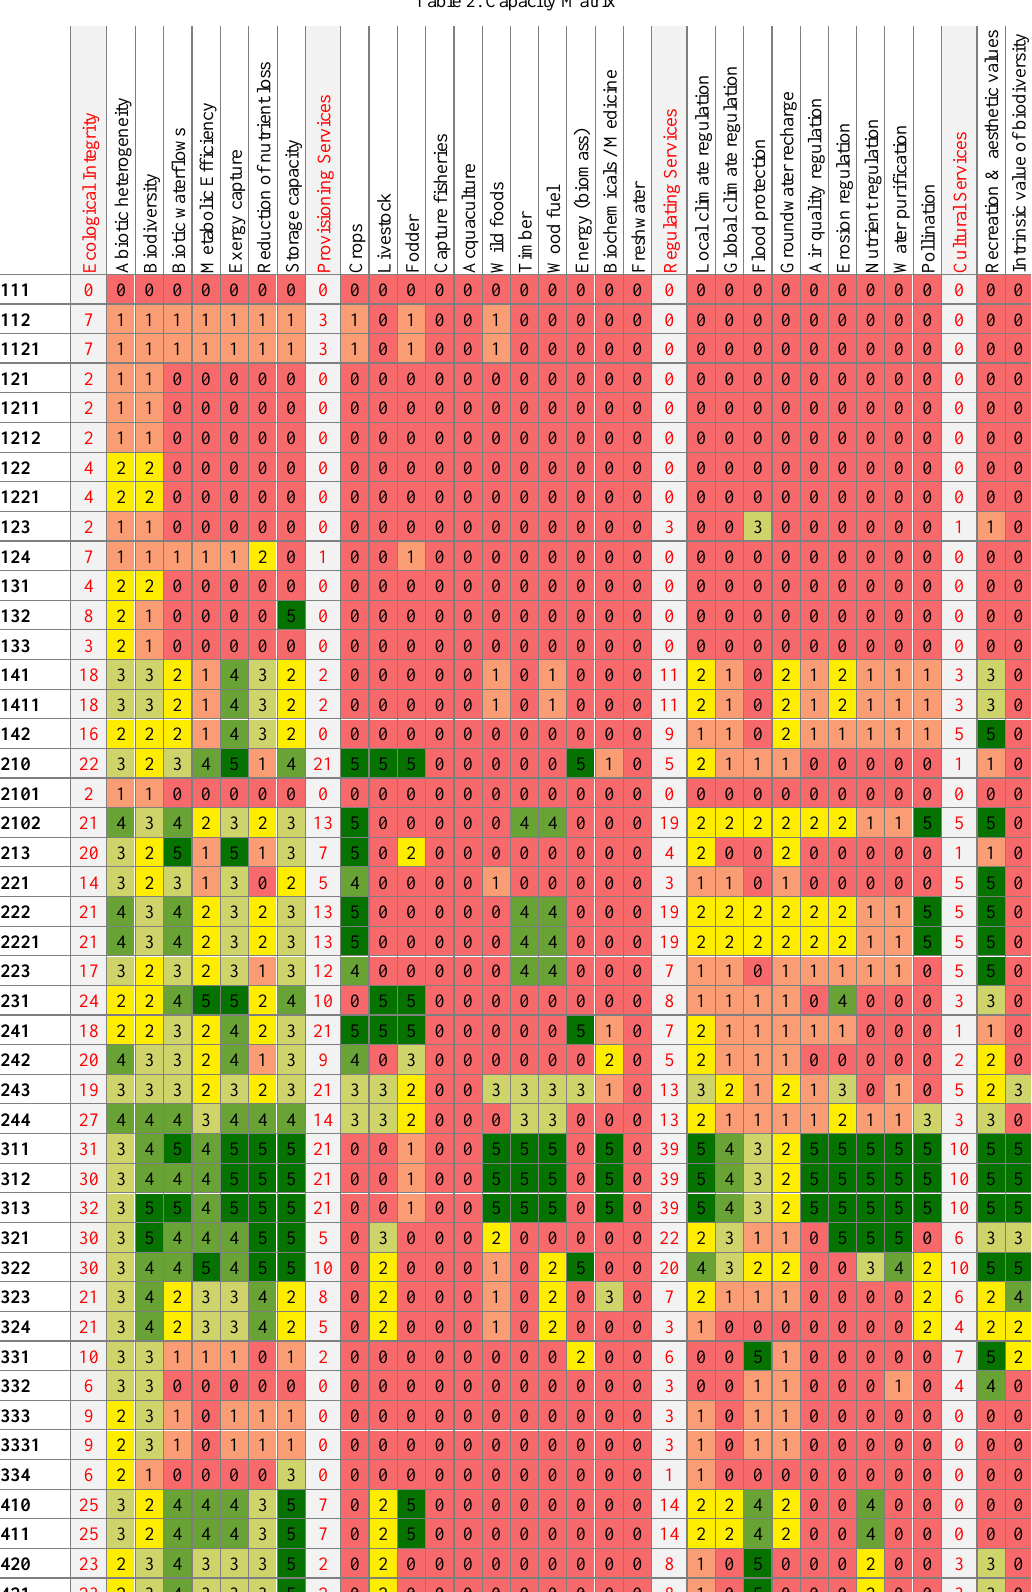
Table 2. Capacity